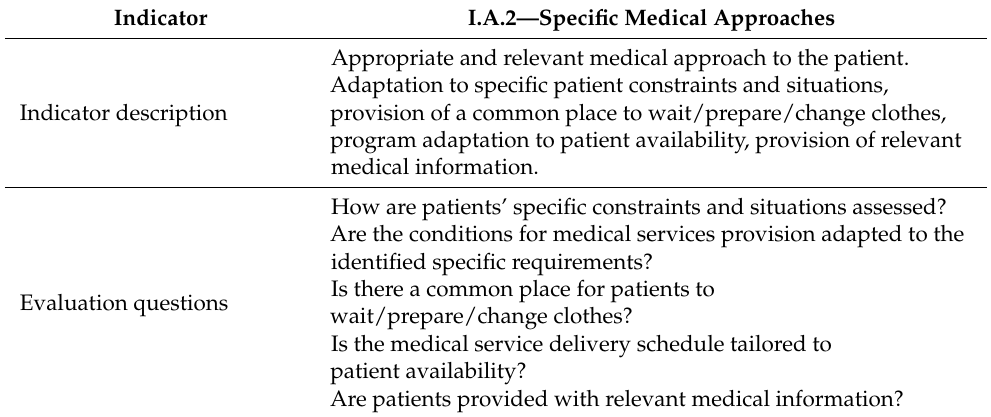
Table 9. The indicator I.A.2—Specific medical approaches.